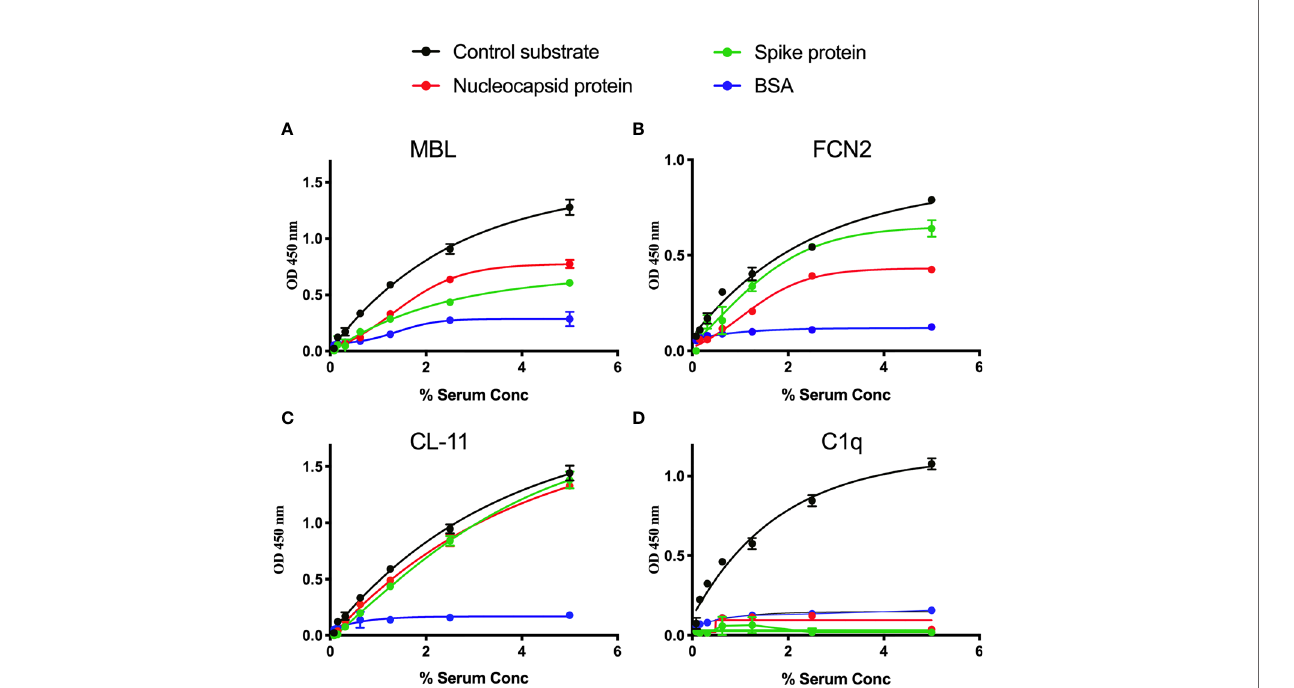
FIGURE 1 | Binding of LP recognition molecules and C1q to SARS-CoV-2 proteins. A microtitre ELISA plate was coated with either S, N or control ligands (mannan for MBL, N-acetyl BSA for FCN2, zymosan for CL-11 or immune complexes for C1q). Following incubation with blocking buffer and washing steps, serial dilutions of NHS, starting at 5% were added to detect binding of LP recognition molecules and C1q from NHS to SARS-CoV-2 proteins. Human MBL (A) , FCN2 (B) , Cl-11 (C) and C1q (D) were assayed by ELISA. A signi fi cant binding of LP recognition molecules to S and N proteins was clearly observed. No C1q binding to any of the viral proteins was detected. Results are means of duplicates ± SD.